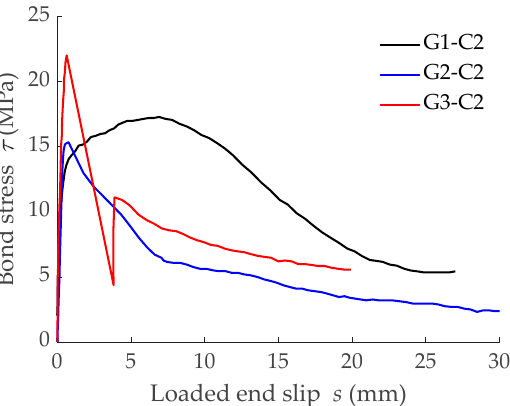
Figure 10. Bond-slip laws between the GFRP bars and high concrete grade (C2) [8].